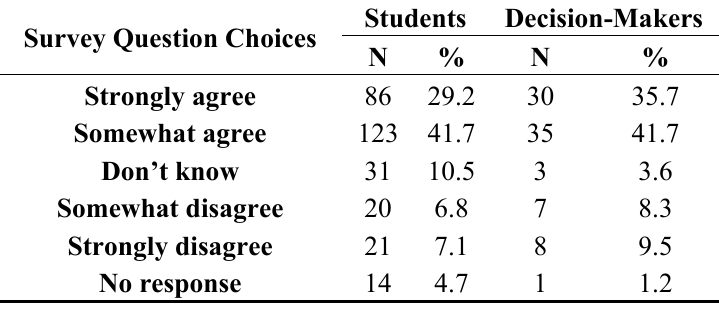
Table 4. Response to “natural climate variability is responsible for climate